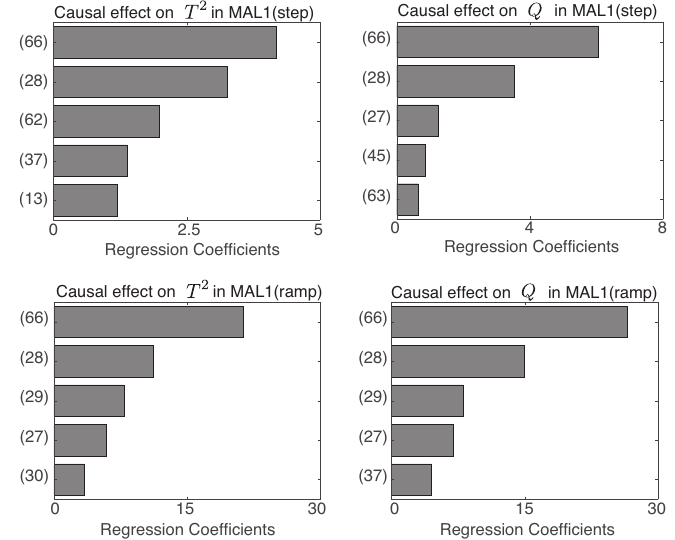
Figure 7. Fault diagnosis results of MAL1 with ramp change by causal plot.